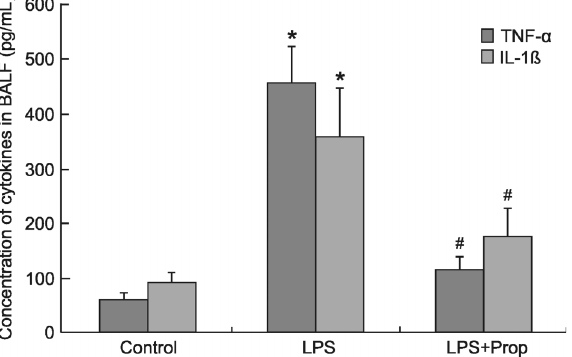
Figure 2. Concentration of TNF- a and IL-1 b in bronchoalveolar lavage fluid (BALF). BALF samples were collected after each animal had received 5 h of intravenous LPS infusion, then examined by ELISA. Data are representative of triplicate experiments with similar results. Data are reported as means ± SD for n = 8 animals per experimental group. *P , 0.05 compared to control; # P , 0.05 compared to LPS group (ANOVA followed by the post hoc Tukey test). TNF- a = tumor necrosis factor- a ; IL-1 b = interleukin-1 b ; LPS = lipopolysaccharide; Prop = propofol.